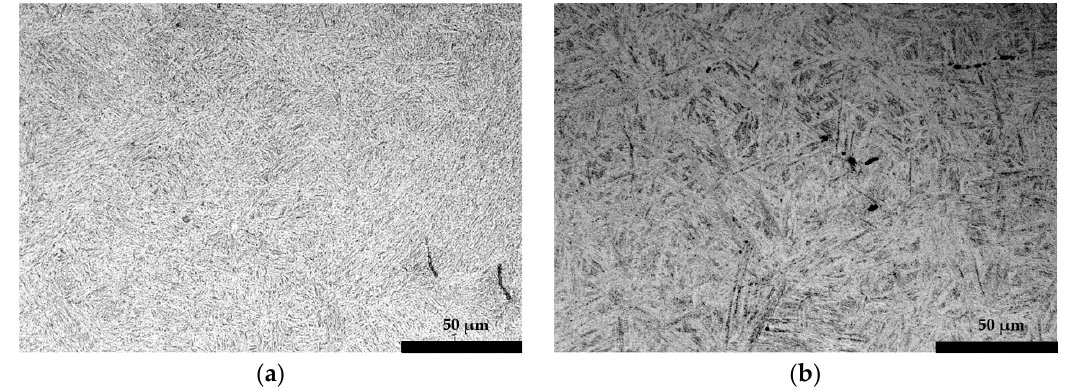
Figure 13. Microstructures taken from ( a ) the cup and ( b ) the bulk areas of the component.